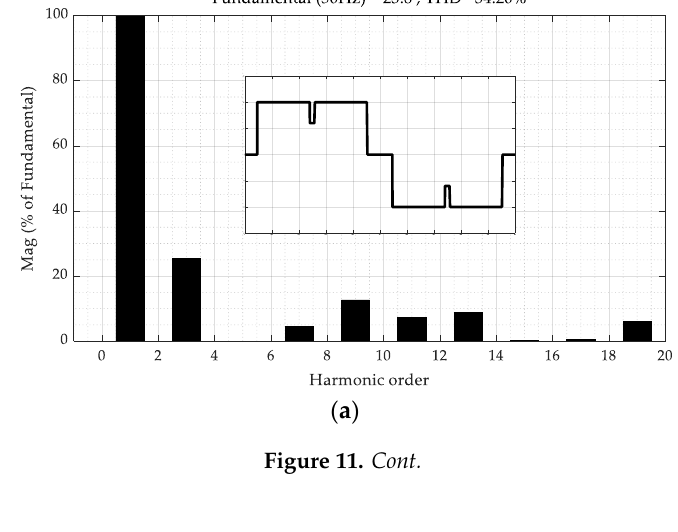
Figure 10. Relationship among MI, x, and the removed harmonic order at the edge additive/subtractive of the DC sources.